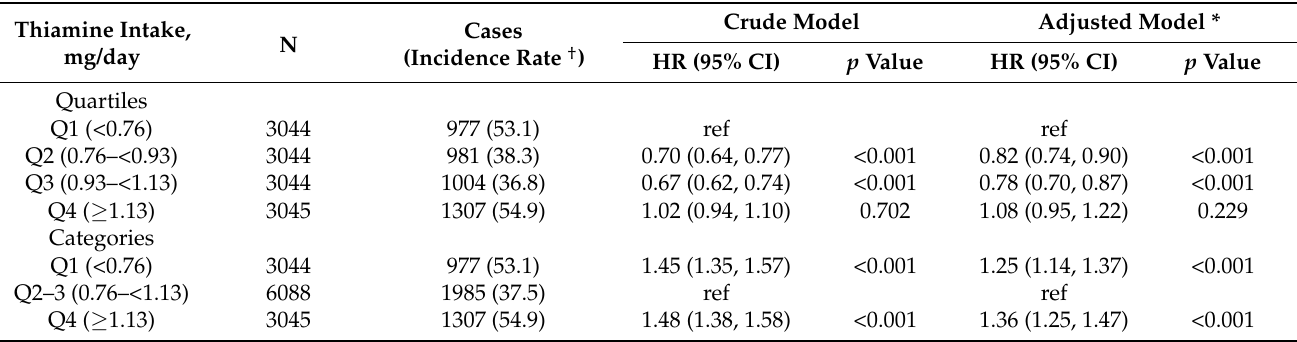
Table 3. Association between dietary thiamine intake and new-onset hypertension.